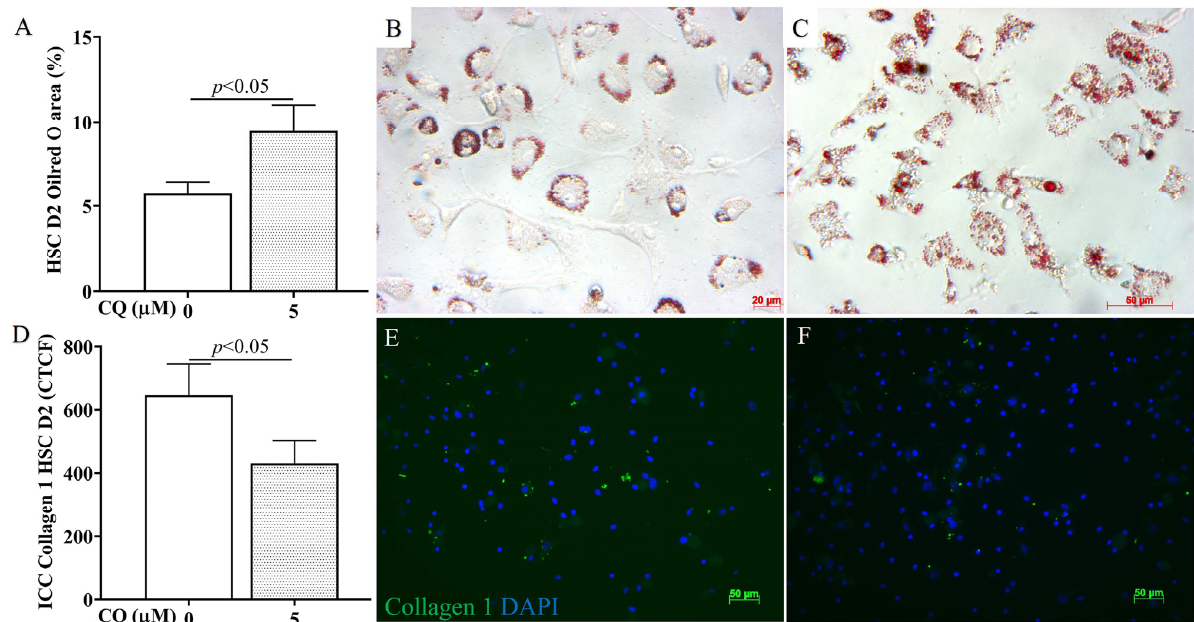
Figure 7. CQ effects on HSC in vitro activation. ( A ) Graphic comparison of Oil red O area (%) between CQ 0 and 5 µM from the ORO staining image. ( B – D ) Graphic comparison of CTCF (Correct Total Cell Fluorescence quantification) from ICC staining with collagen 1 antibody/DAPI ( E , F ) between CQ 0 and 5 µM. * p -value < 0.05, n = 3, 50 µm scale bar.